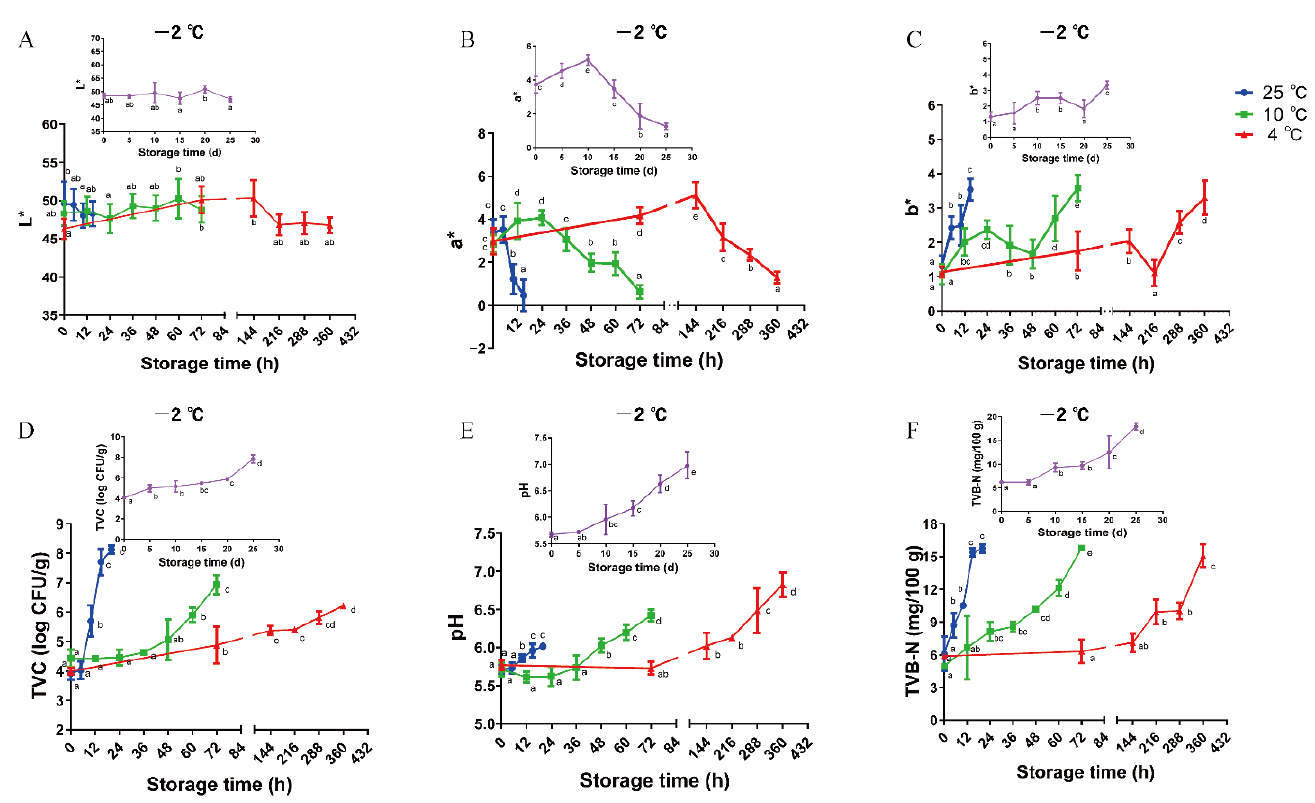
Figure 1. Changes in L* ( A ), a* ( B ), b* ( C ), TVC ( D ), pH ( E ), and TVB-N ( F ) in pork under storage at − 2, 4, 10, and 25 °C. Error bars indicate the standard deviation of four repeated experiments. The different letters (a–e) indicate significant differences between different storage times under the same temperature ( p < 0.05).